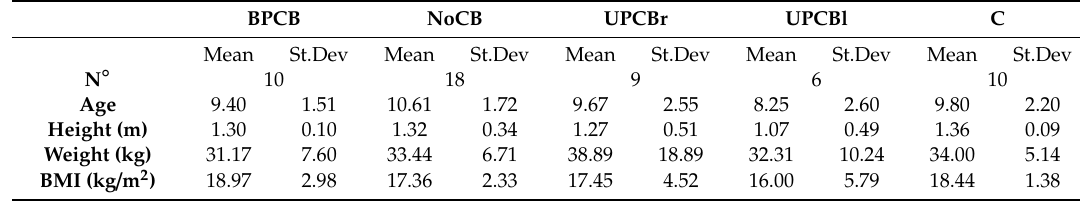
Table 1. clinical and anamnestic data of our